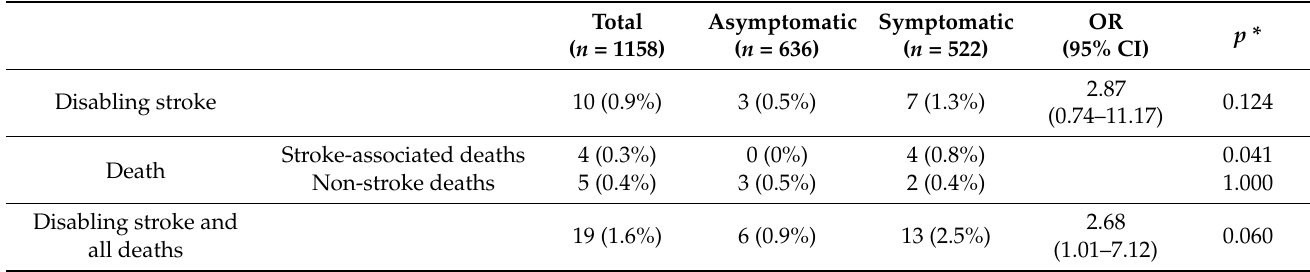
Table 6. Primary